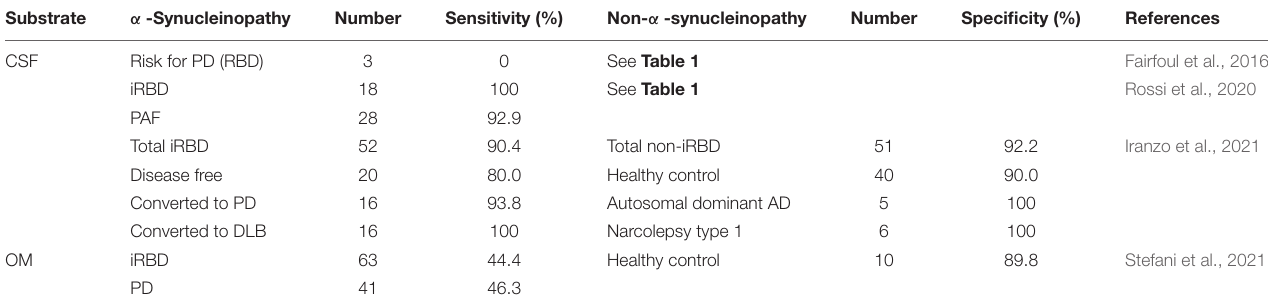
TABLE 3 | Sensitivity and specificity of RT-QuIC in patients at the prodromal stage of α -synucleinopathy. Substrate α -Synucleinopathy